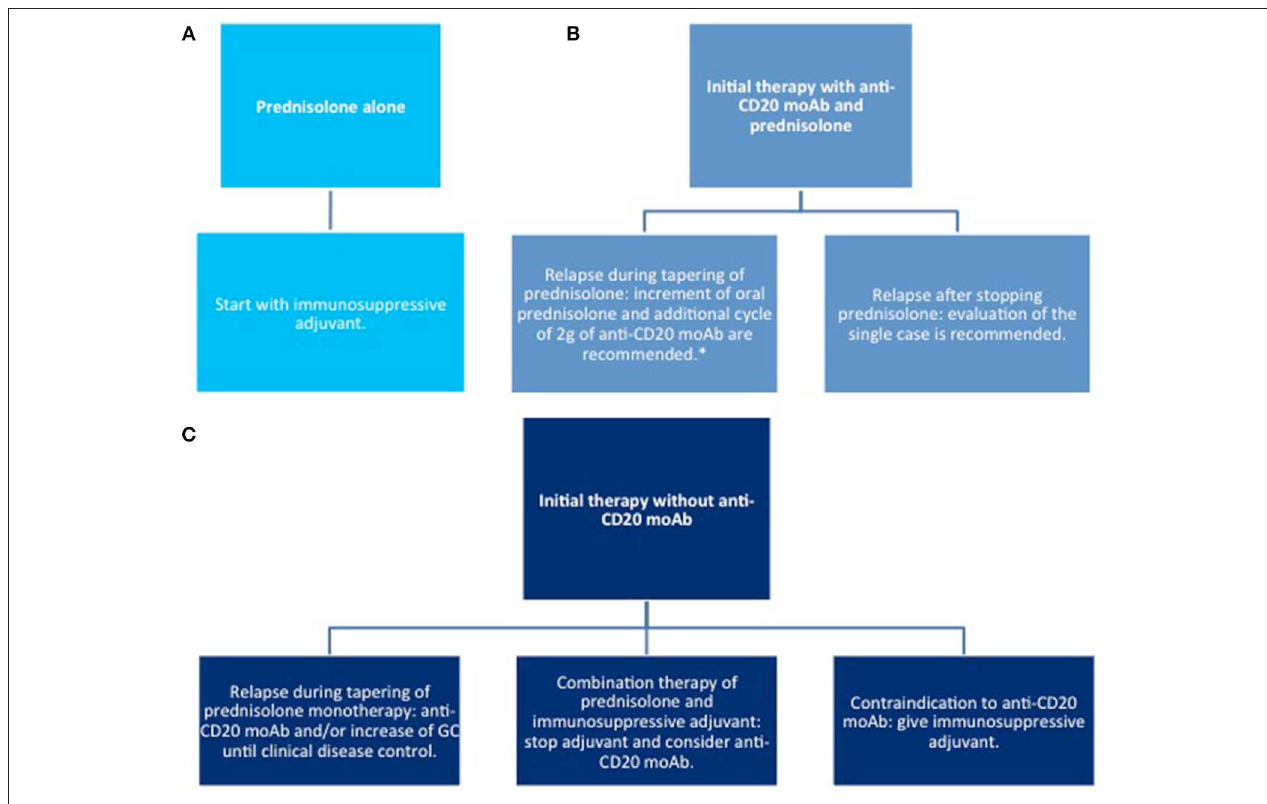
FIGURE 7 | Therapy of relapse. (A) with corticosteroids only; (B) systemic corticosteroids combined with anti CD20 moAb; (C) systemic corticosteroids combined with other immunosuppressive agents. moAb, monoclonal